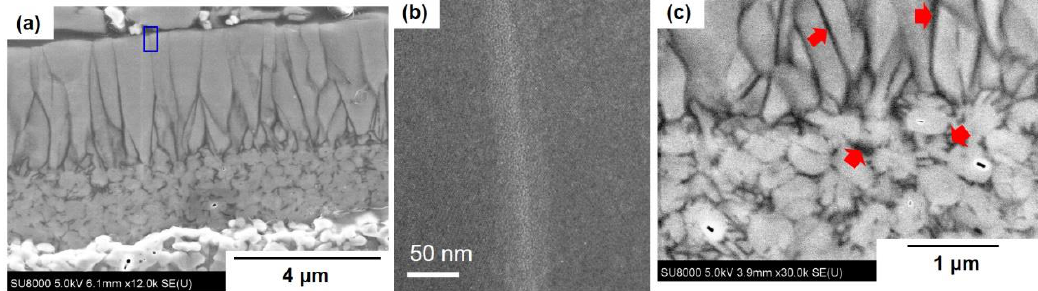
Figure 10. TEM images of a cross-section of a silicalite-1 membrane crystallized for 168 h. ( a ) Wide view, ( b ) grain boundary near-surface (an area divided blue square), and ( c ) interface between seed and columnar crystal layer. Arrowheads in ( c ) show defects among seed crystals and grain boundaries between columnar crystals.